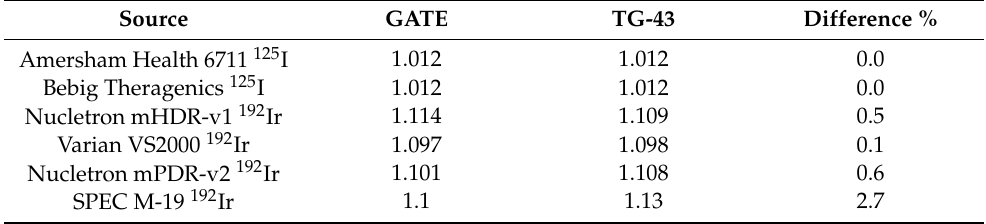
Table 2. Dose Rate Constant (in cGy h-1 U-1), for all seeds, when simulation output is compared with TG-43